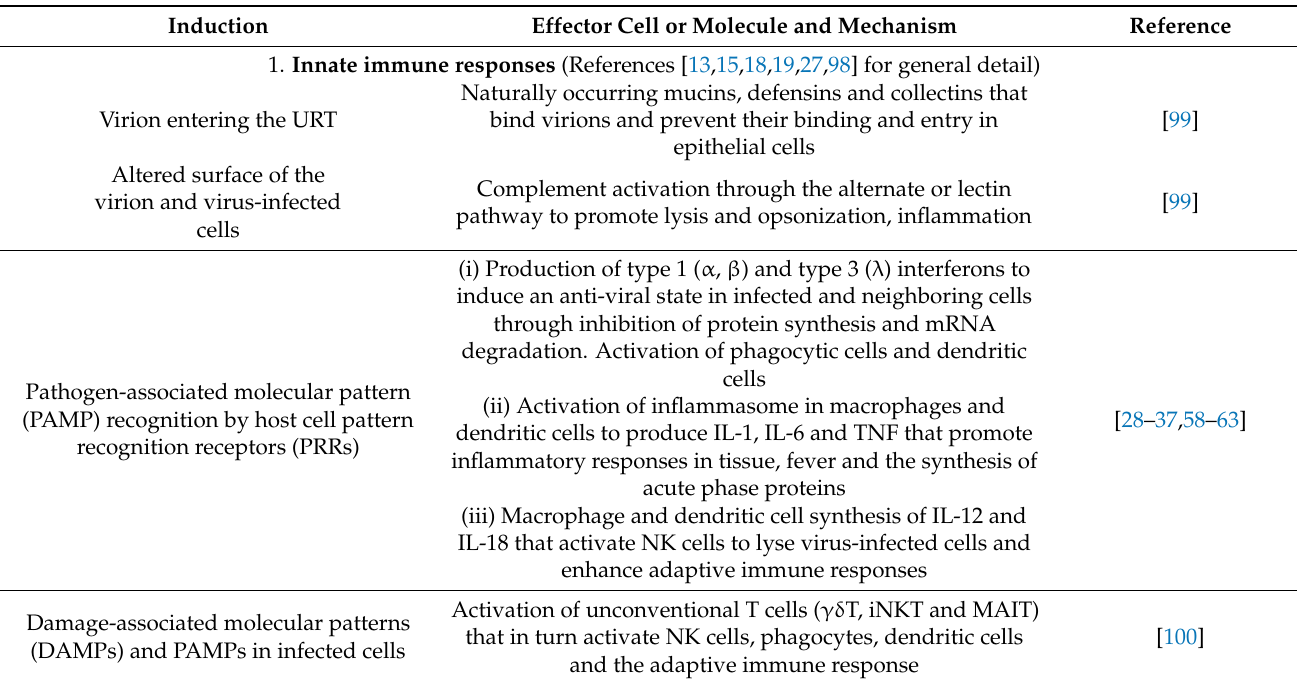
Table 1. Potential and established protective innate and adaptive immune mechanisms against SARS-CoV-2 in the upper respiratory